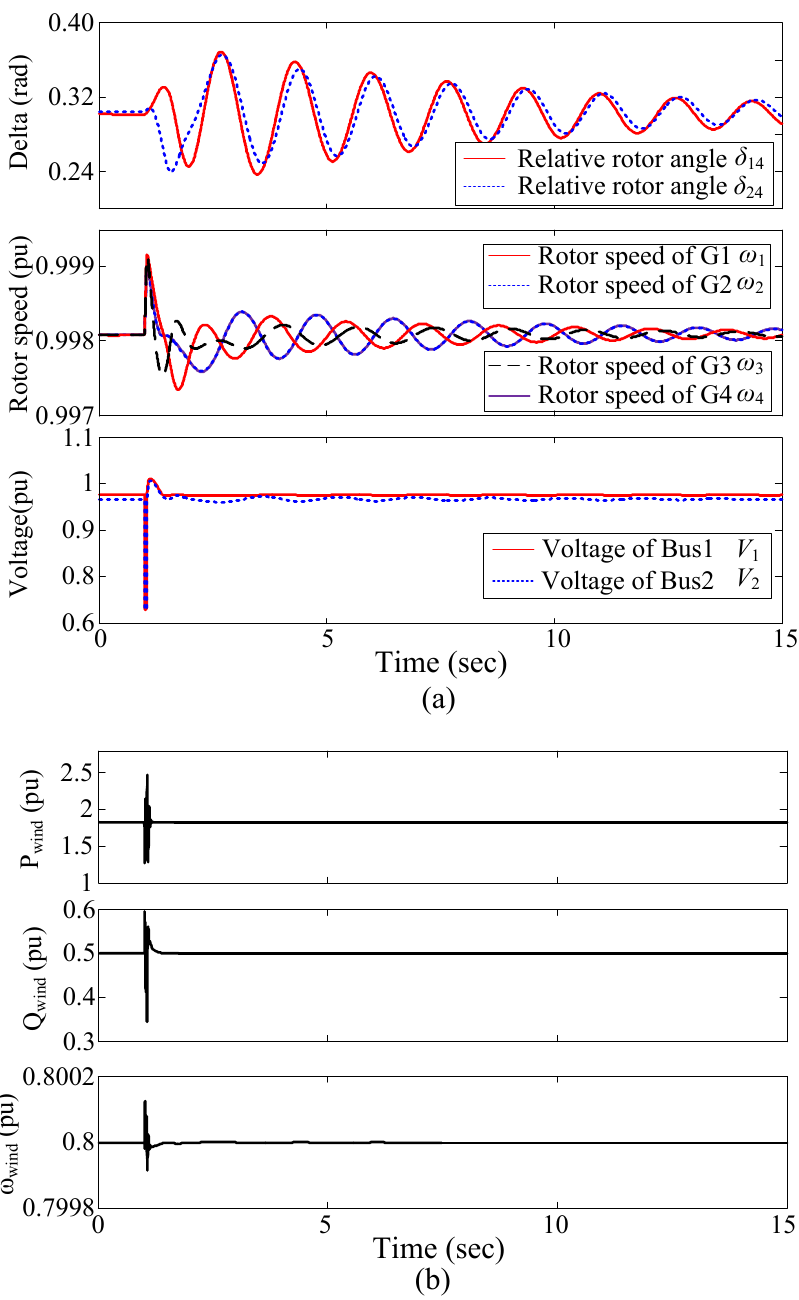
Figure 8. System dynamic performances without additional damping control for DFIG. ( a ) Generators dynamics, from up to bottom: δ 14 and δ 24, rotor speeds of the generators, buses voltage; ( b ) DFIG dynamics, from top to bottom: active power of DFIG, reactive power of DFIG, and rotor speed of